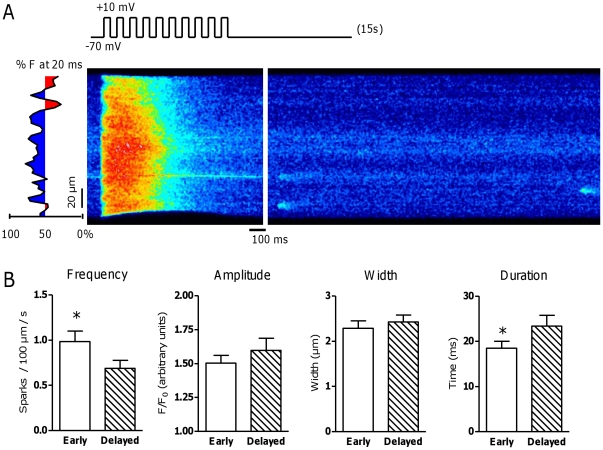
Effect of proximity of TTs to RyR on spontaneous Ca2+ sparks.A. Typical example of a line scan image during and after 1 Hz stimulation. After loading the SR with conditioning pulses from −70 to +10 mV at 1 Hz, stimulation was stopped and 15 seconds of diastole were recorded for Ca2+ sparks. Sparks were assigned to early (blue) and delayed (red) release areas corresponding to their position on the scan line. B. Spark frequency and morphology in early vs. delayed release areas in CTRL pigs (Npigs = 12, ncells = 41). * denotes P<0.05.